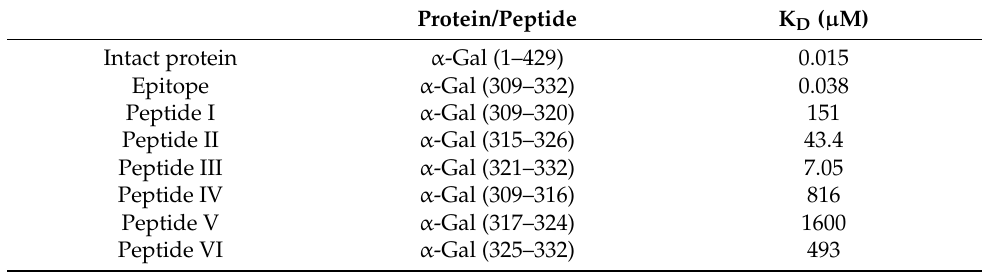
Table 2. Binding affinities of full length α -Gal protein and α -Gal epitope peptides determined by